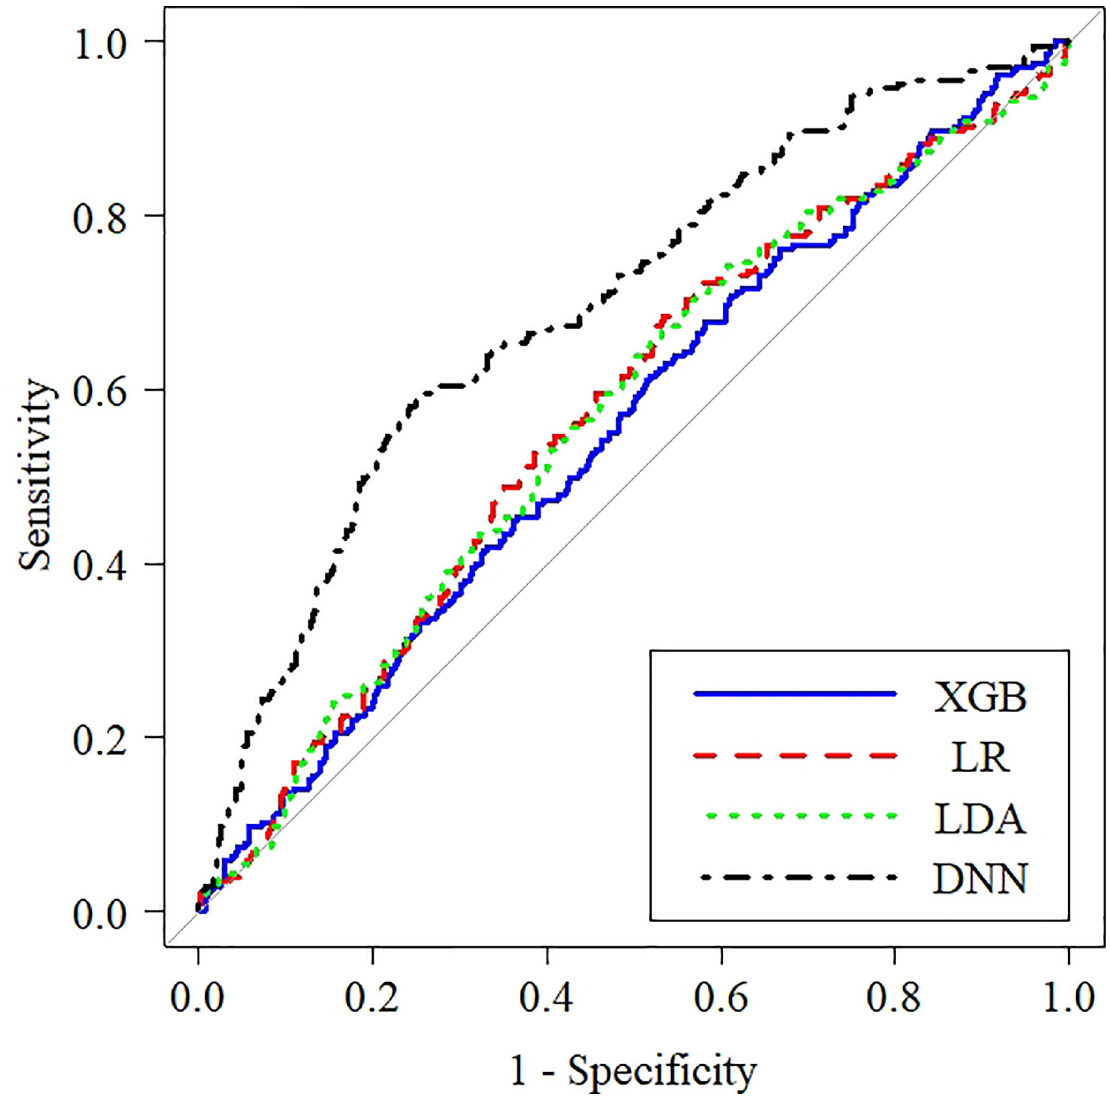
Fig 3. Receiver operating characteristic curves of machine learning methods for predicting postinduction hypotension in the test data set. The greater the area under the receiver operating characteristic curve, the higher the discriminative ability of the model. LR; logistic regression, LDA; linear discriminant analysis, XGB; gradient boosting machine, DNN; deep neural network.